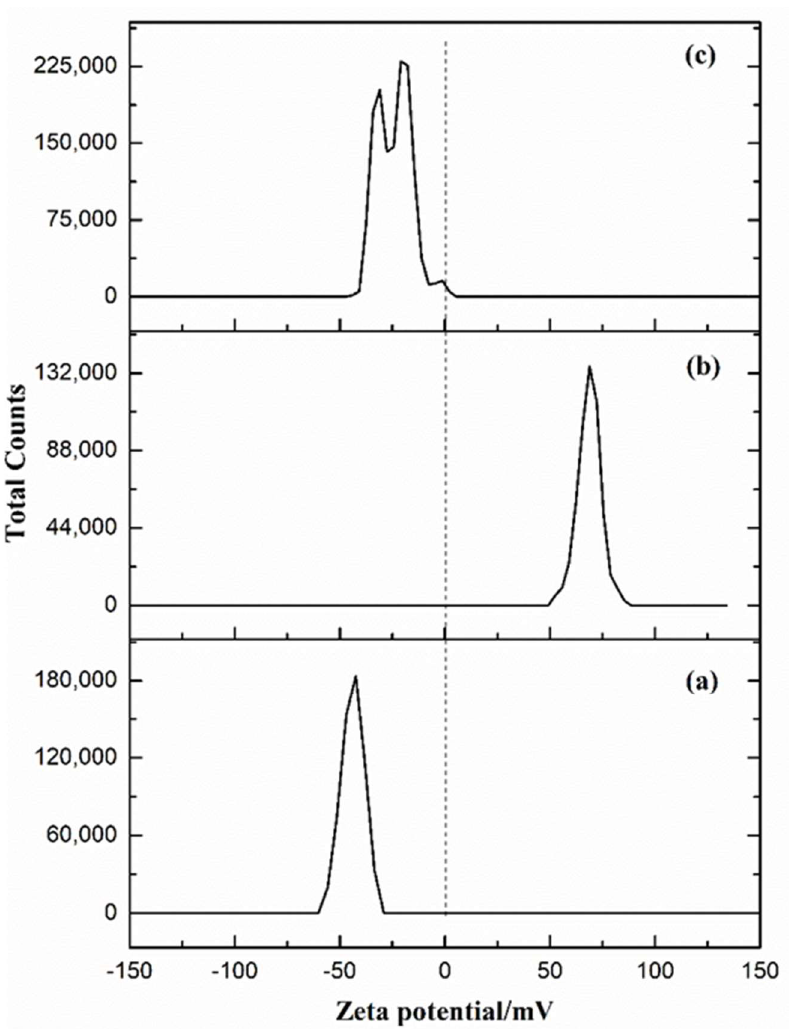
Figure 1. Zeta potentials of ( a ) SA, ( b ) CS and ( c ) Type B GT.